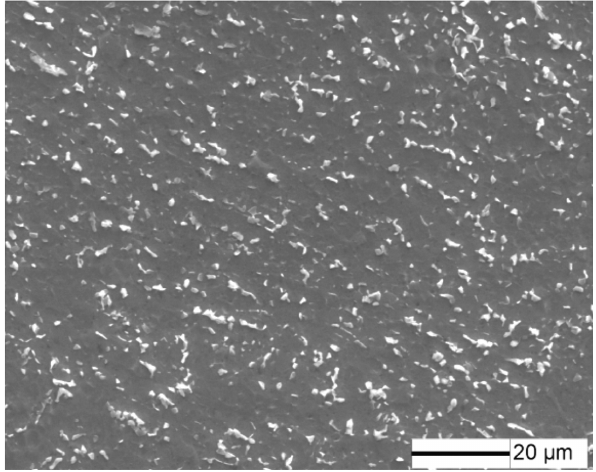
Table 2: The tensile velocity parameters of the tensile